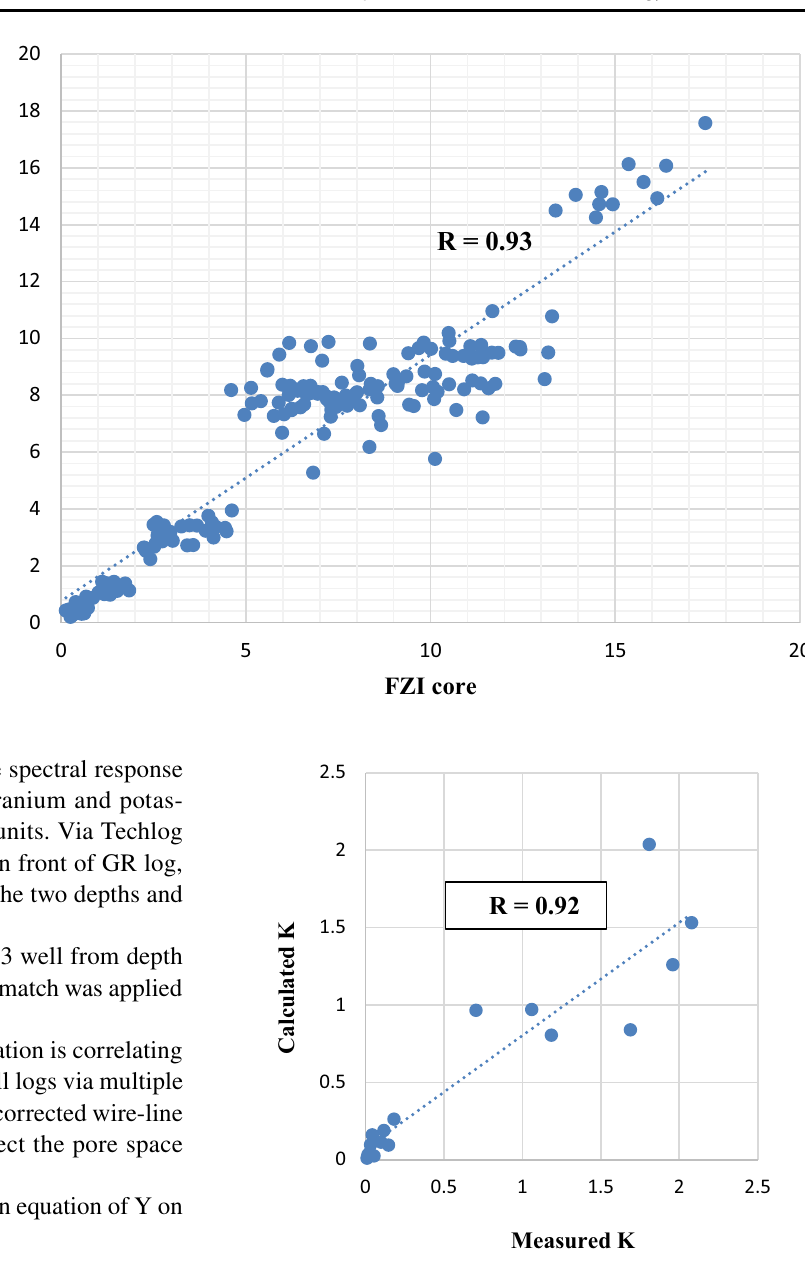
Fig. 11 Cross-plot of measured permeability versus calculated one